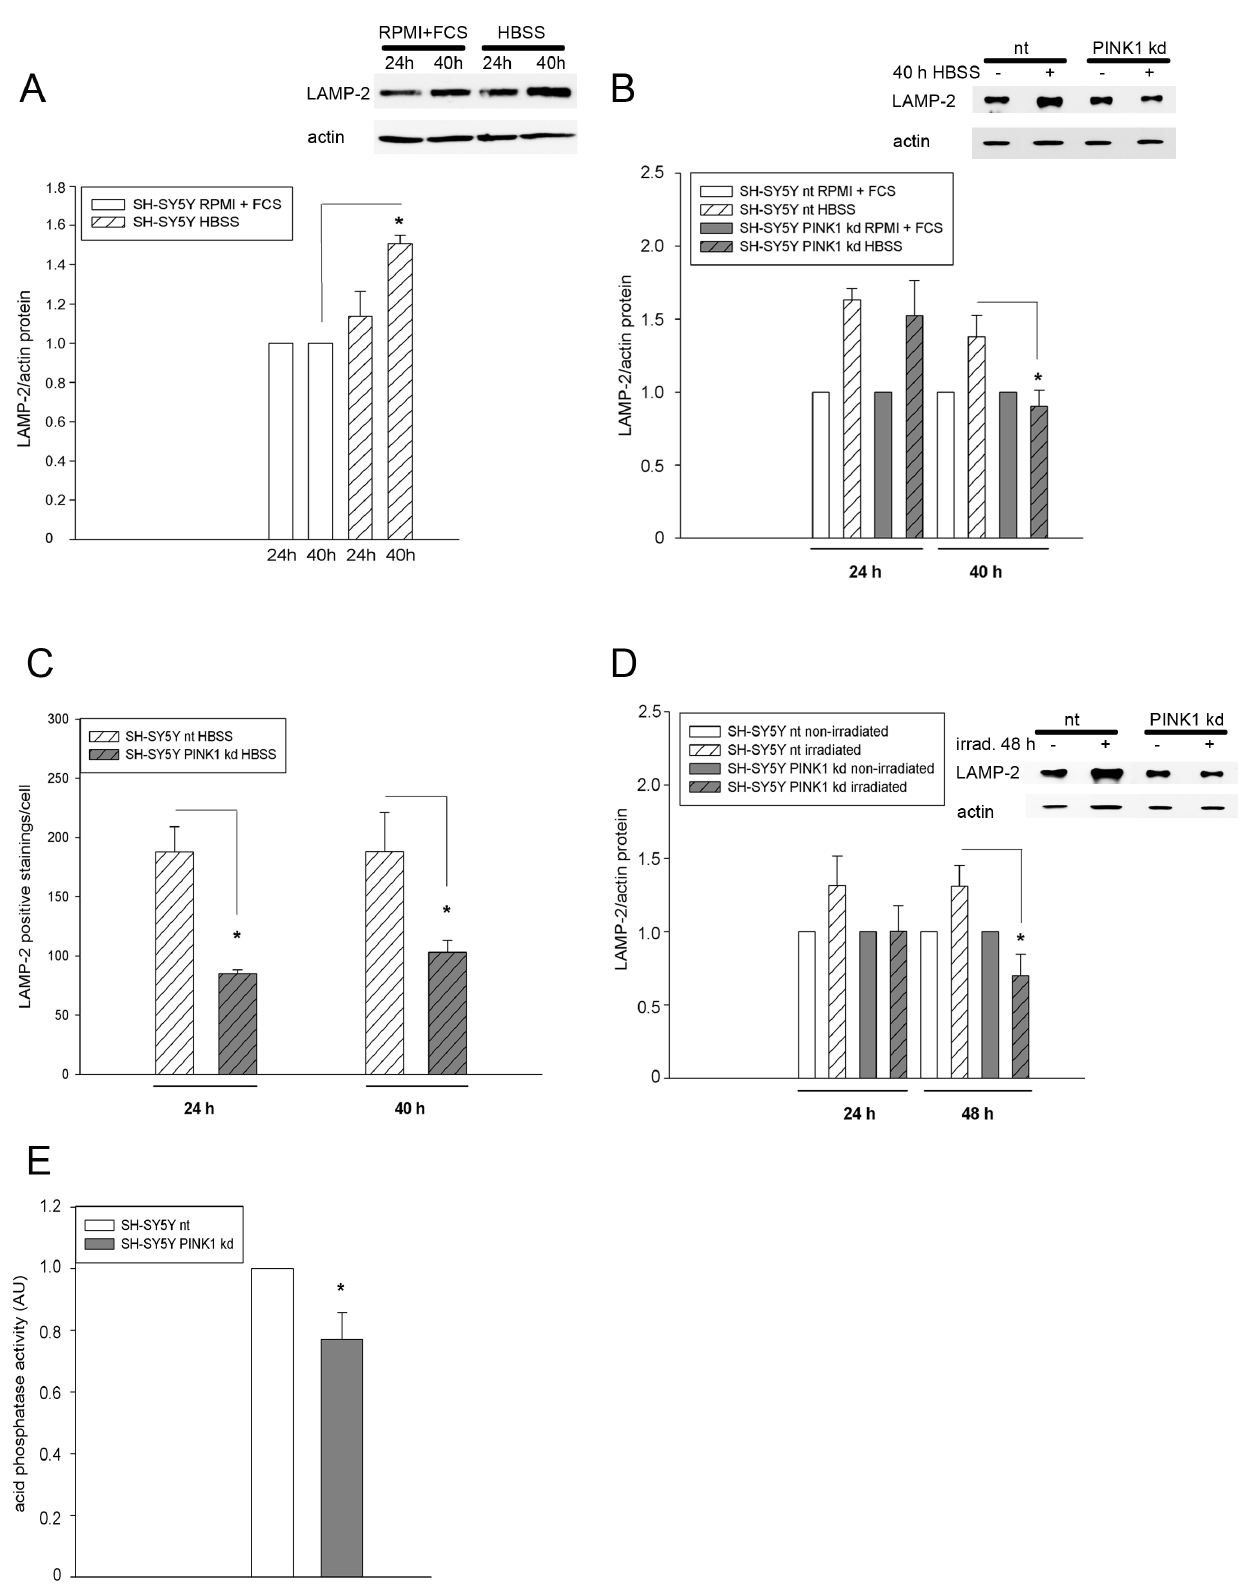
Figure 3. Reduced LAMP-2 expression after PINK1 knockdown. 3A) Regular, non-transduced SH-SY5Y cells were cultivated either in RPMI + 10% FCS or starved in HBSS medium for 24 and 40 h. The LAMP-2 and actin content were determined by western blotting and the relative LAMP-2 content of untreated cells was set as 1. Starvation enhanced LAMP-2 protein levels; n=3, p , 0.05. 3B) Transduced nt and PINK1 knockdown (kd) SH-SY5Y cells were cultivated either in RPMI + 5% FCS or starved for 24 h and 40 h in HBSS. The LAMP-2 and actin content were determined by